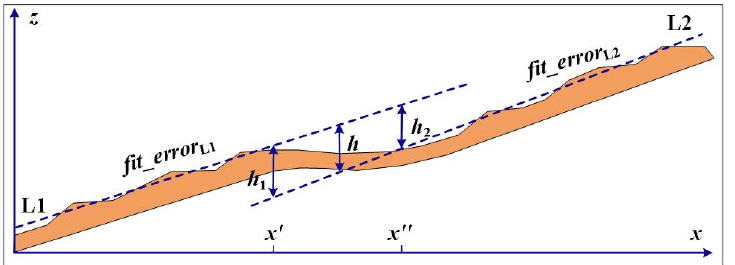
Figure 6. Schematic diagram of the measurement results and errors of the vertical offset [37].